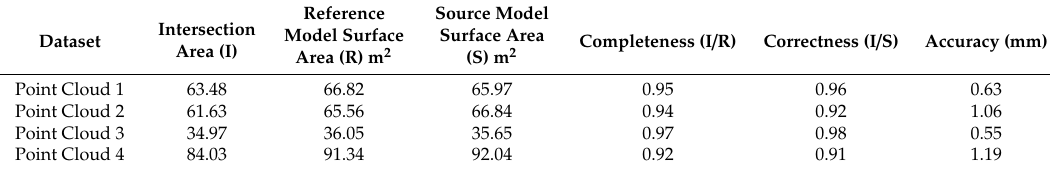
Figure 18. Reference cable well models. ( a ) Point Cloud 1 reference models, ( b ) Point Cloud 2 reference models, ( c ) Point Cloud 3 reference models, and ( d ) Point Cloud 4 reference models. Table 3. The quantitative evaluation of Completeness, Correctness and